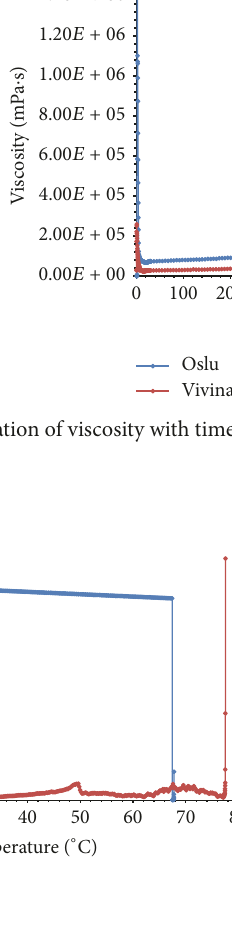
Figure 4: Variation of viscosity with temperature at constant shear rate (10s −1 ) during